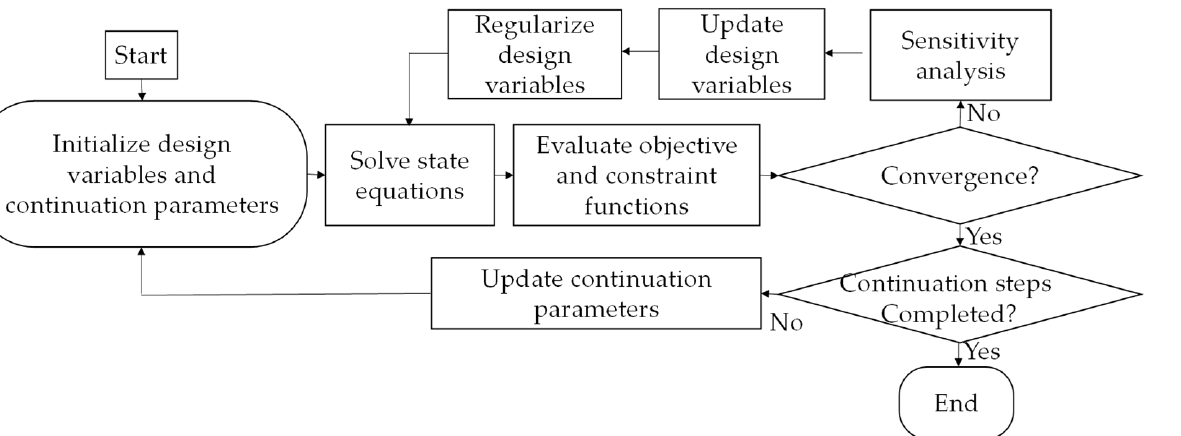
( b ) Figure 4. A single unit cell of ( a ) diamond ‐ sheet structure; ( b ) gyroid ‐ sheet structure for fulfilling the optimal results in this study. 4. Results and Discussion In this section, two main parts are presented. For the topology optimization, the prob ‐ lem setup and 2D simplified model validation are detailed in the first part. The optimal density distribution in the 2D optimized model is extruded into the 3D domain and ful ‐ filled with the TPMS structures. The final designs are then recalculated and validated in the second part. The pressure drop, heat transfer and temperature uniformity are com ‐ pared with the baseline serpentine channels. 4.1. 2D Optimization 4.1.1. Validation of the 2D Model Since the 3D channel is simplified into the 2D model to reduce the computational cost for topology optimization, the accuracy of the stated variable field obtained from 2D cal ‐ culations should be satisfied [19]. Air and copper are selected in this work for fluid and solid properties for the simulation. The boundary conditions and governing equations explained in Section 2 are used to compute the flow, turbulence effect and heat transfer. It should be marked that in COMSOL, the out ‐ of ‐ plane heat flux ( q 0 ) in the 2D model is equivalent to the uniform heat flux boundary in the 3D system.